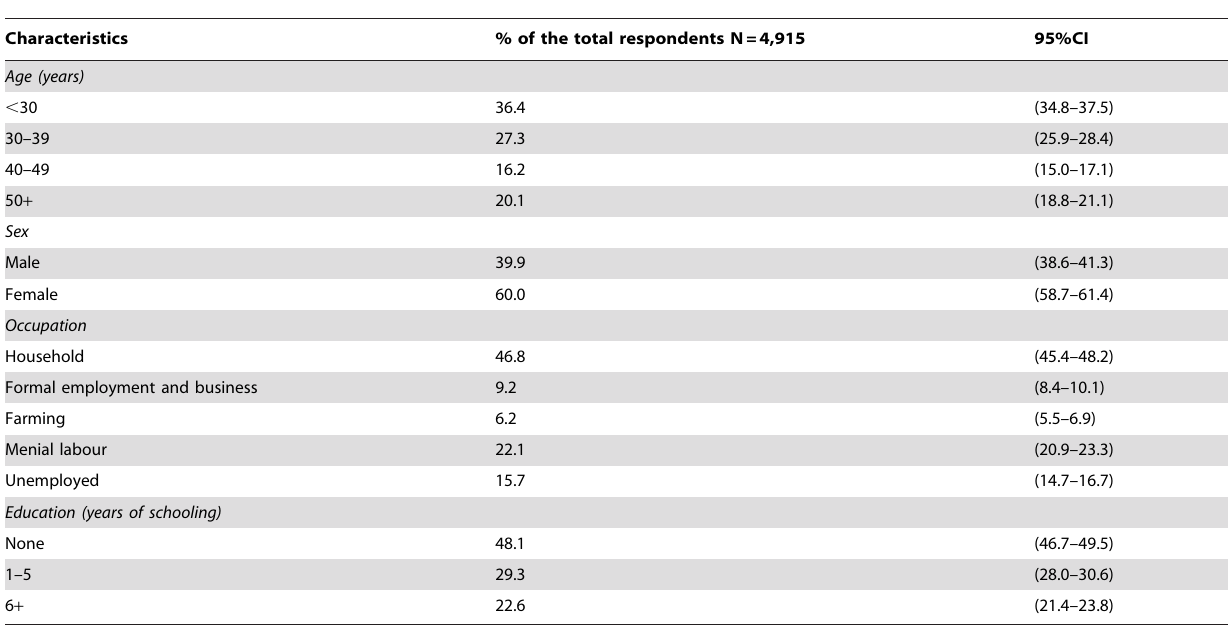
Table 1. Characteristics of